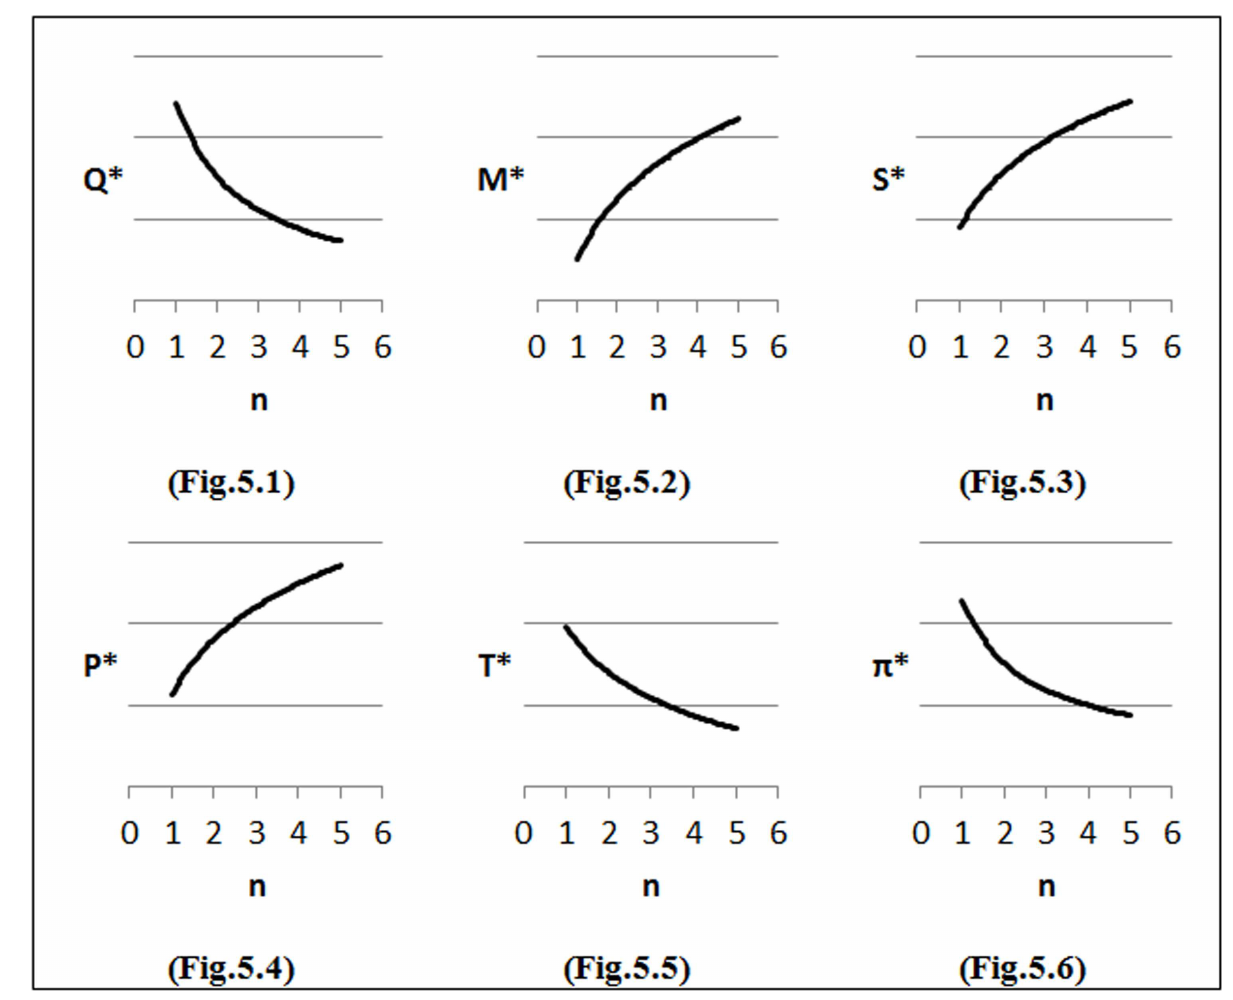
Fig 5. Effects of changes in ( i ) on decision